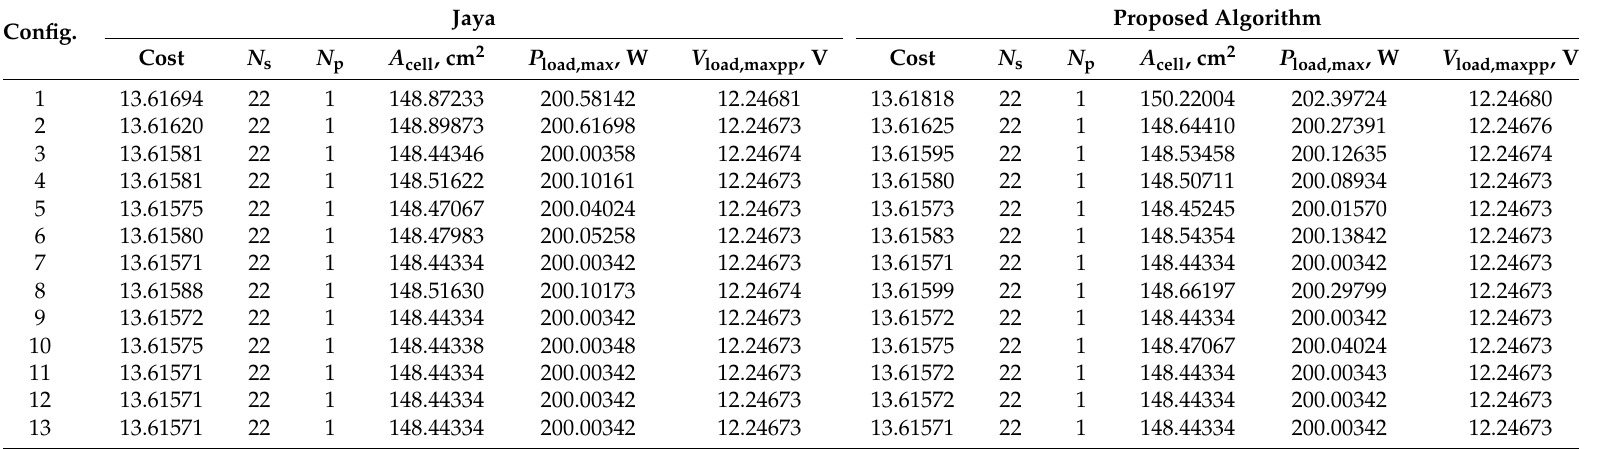
Table 16. Best of best-of-run solutions (stack designs). Current step size = 1 mA.